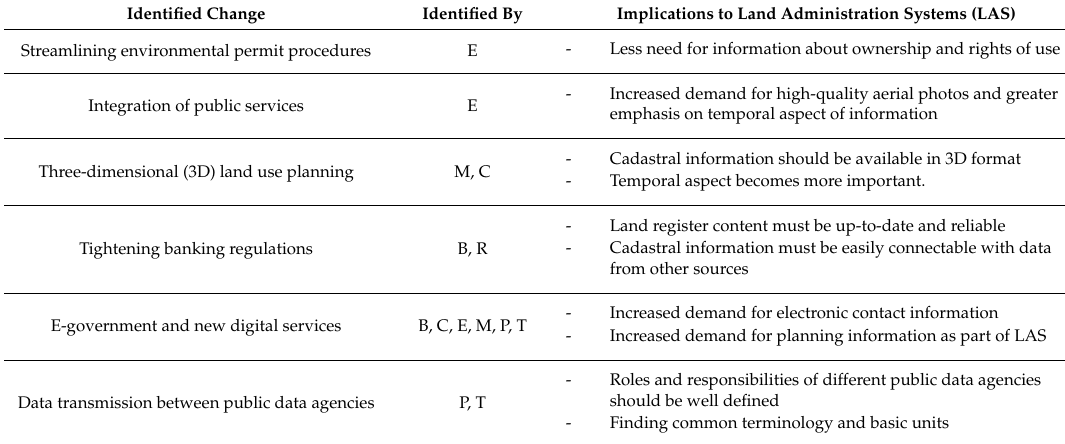
Table 2. Summary of